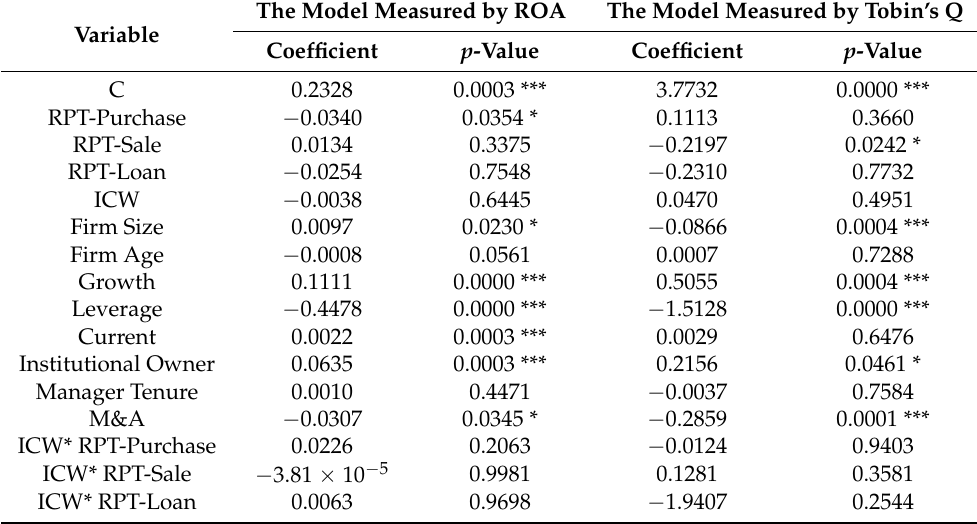
Table 7. The results of the second